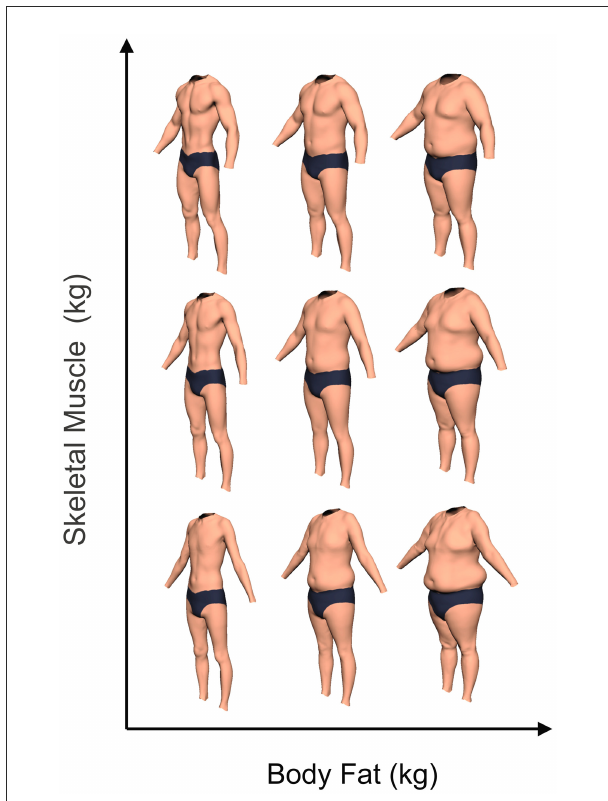
FIGURE2 Examples of the CGI body stimuli used in this study illustrating how the bodies change as body composition